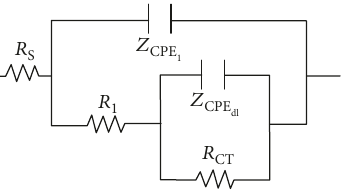
Figure 12: Equivalent circuit used to fi t the impedance